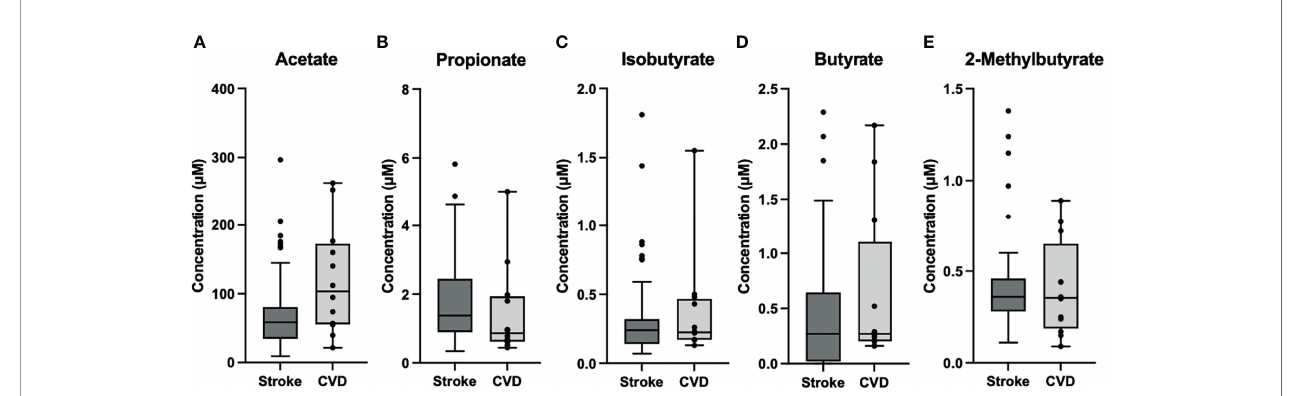
FIGURE 1 | Box and Whisker Plots of Stroke (n=53) vs CVD Control (n=12). (A) Acetate was signi fi cantly lower (p=0.02) in stroke (M=73.1, SD=57.5) compared to control (M=120.6, SD=80.0). (B – E) Propionate (M S = 1.8, SD S =1.3; M C =1.44, SD C =1.35), Isobutyrate (M S =0.33, SD S =0.33; M C =0.38, SD C =0.39), Butyrate (M S =0.43, SD S =0.54; M C =0.63, SD C =0.72), and 2-Methylbutyrate (M S =0.41, SD S =0.26; M C =0.41, SD C =0.26) were comparable between groups. )M S = Stroke Mean, SD S = Stroke Std. Dev.; M C = Control Mean, SD C =Control Std. Dev.).